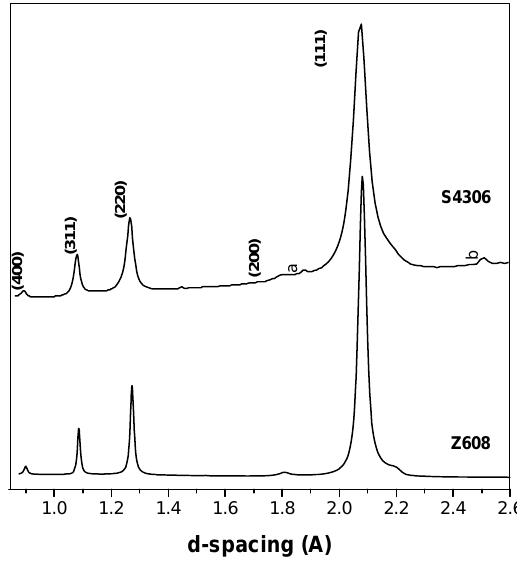
Figure 4. XRD patterns of samples S4306 and Z608 taken with monochromatic synchrotron radiation. Two minor reflexions labelled a and b and the shoulders of the main peak in the Z608 sample do not correspond to the cubic